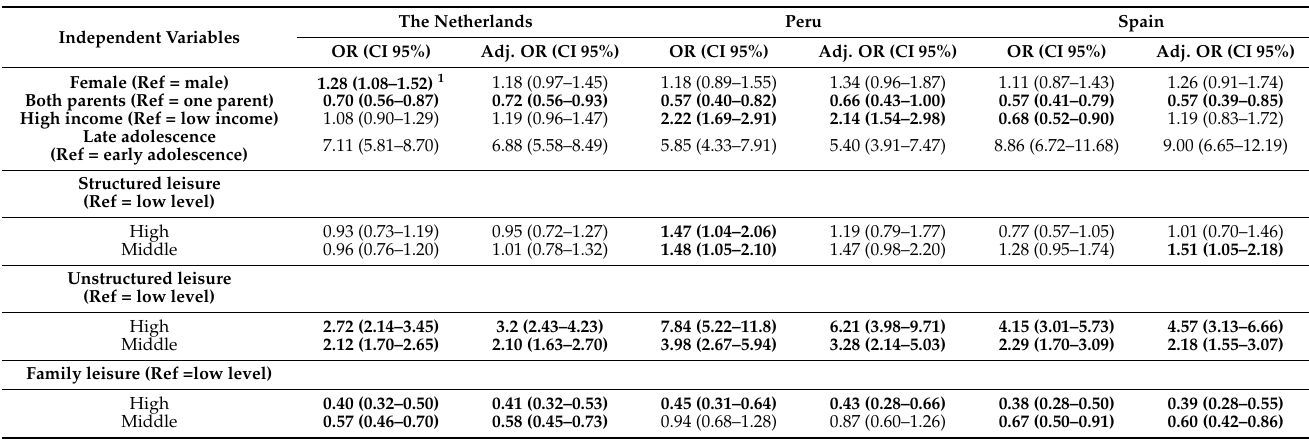
Table 4. Odds ratio estimated and 95% confidence limits for yearly alcohol use (YAU) in each country, raw and adjusted by